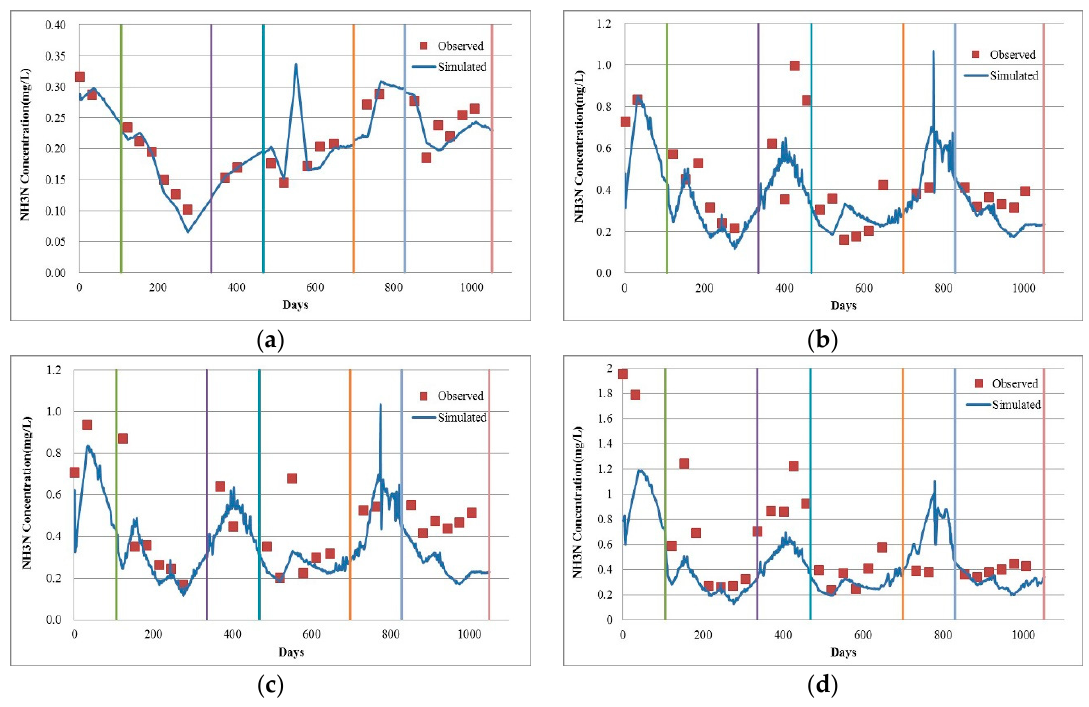
Figure 7. Result comparison for observed and simulated values of NH 3 N in the Mudan River trunk stream. ( a ) Wenchun Bridge; ( b ) Hailang; ( c ) Jiangbin Bridge; ( d ) Chai River Bridge. Table 3. Statistical analysis for simulation and observed values of NH 3 N in the Mudan River trunk stream model.